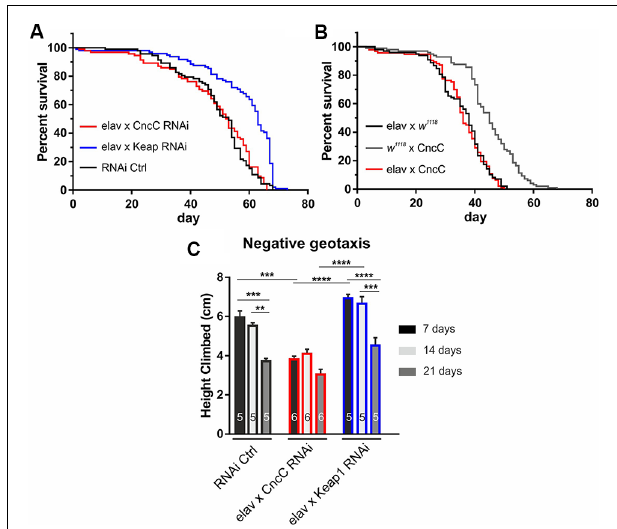
FIGURE 1 | Suppression of Kelch-like ECH associated protein 1 ( Keap1 ) signaling extends life span and promotes negative geotaxis activity. (A) RNAi silencing of Keap1 prolongs life span, whereas CncC downregulation does not affect longevity ( n = 60–98 flies, p < 0.0001). (B) Overexpression of CncC does not affect life span ( n = 99–72 flies, p > 0.05). Data were compared using the Log-rank (Mantel-Cox) test. (C) Negative geotaxis performance declines with age in control flies (RNAi Ctrl at 21 days, dark gray), however, CncC RNAi expression induces a strong reduction in climbing activity at 7 days (black) with no further effects at older ages. RNAi silencing of Keap1 augments activity decline relative to CncC silencing at seven (black) and 14 (light gray) days ( n —number of flies indicated within bars). Data denote mean ± SEM for all data comparisons in (C) . One-way ANOVA with post